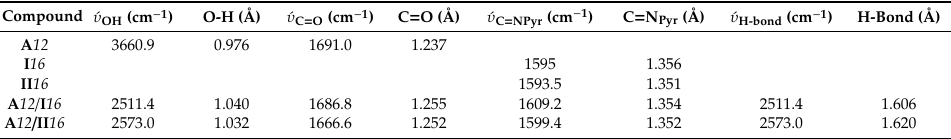
Figure 1. The Fourier-transform infrared spectroscopy (FTIR) spectrum of acid A 12 , azopyridine bases, I 16 and II 16 , as well as their 1:1 supramolecular complexes A 12 /I 16 and A 12 II 16 . Table 1. The calculated bond length (Å) wavenumbers (cm − 1 ) of characteristic groups of A 12 , I 16 , II 16 , A 12 / I 16 and A 12 / II 16 .